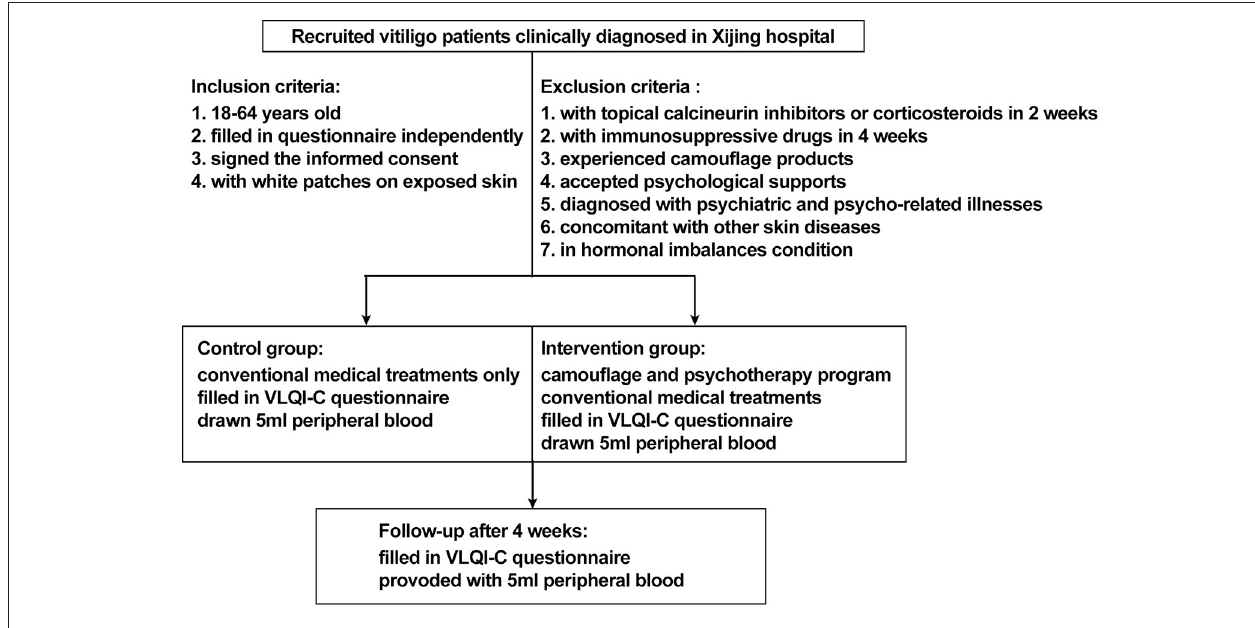
FIGURE 1 | Overview of trial design.